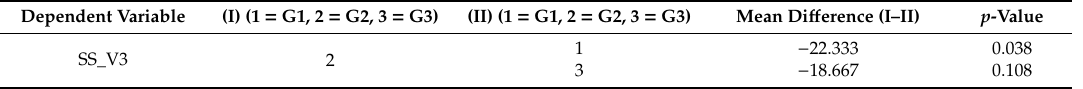
Table 4. Comparison of severity score of G2 (MegaSporeBiotic) with G1 and G3.